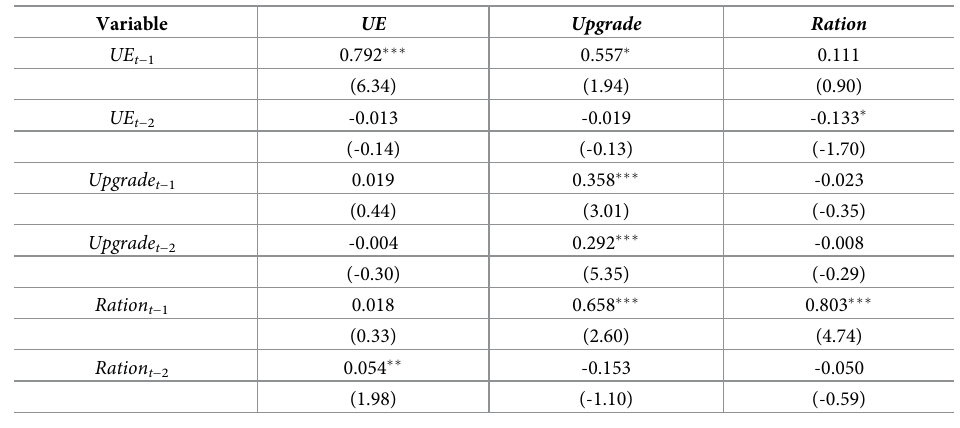
Table 4. Parameter estimation results of the PVAR model. Variable UE Upgrade Ration UE t − 1 (1.94) (0.90) UE t − 2 -0.013 -0.019 -0.133 � (-0.14) (-0.13) (-1.70) Upgrade t − 1 0.019 (0.44) (3.01) (-0.35) Upgrade t − 2 -0.004 (-0.30) (5.35) (-0.29) Ration t − 1 0.018 (2.60) (4.74) Ration t − 2 0.054 �� -0.153 -0.050 (1.98) (-1.10) (-0.59) Note: The values in brackets are T values � , �� and ��� respectively represent a significance level of 10%, 5%and